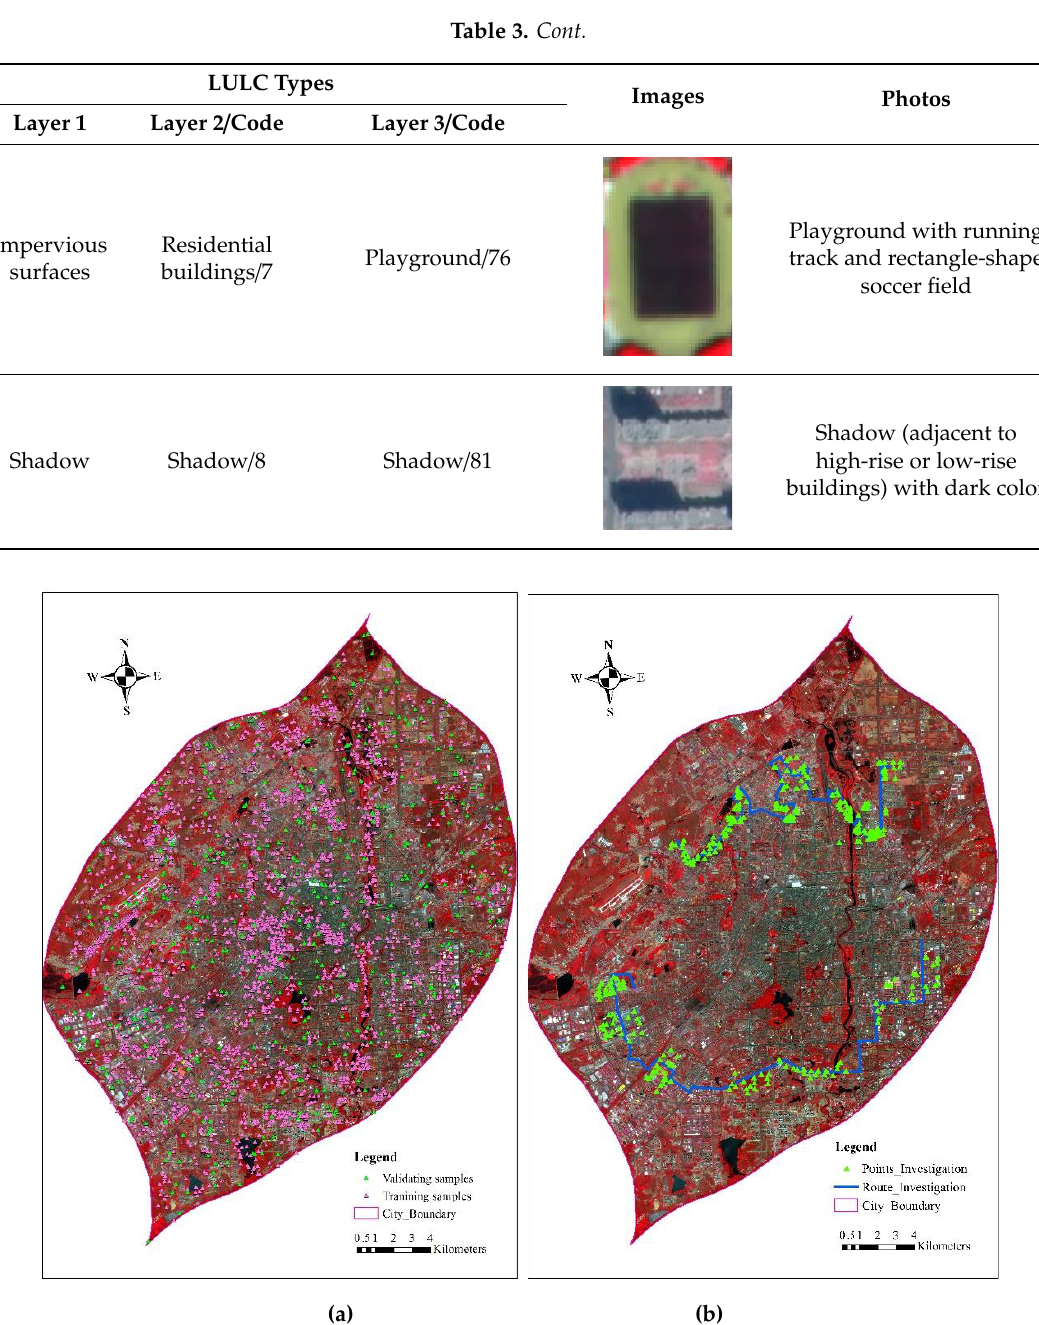
Figure 2. Land use land cover samples collection and field investigation, ( a ) collected training and testing samples; ( b ) field work route and investigation sites.